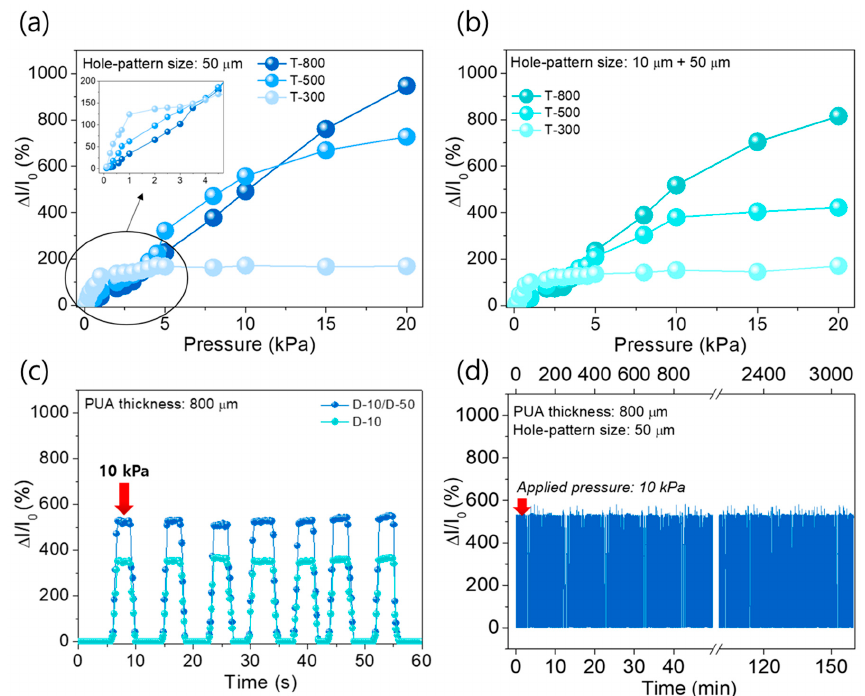
Figure 3. Analysis of static response and dynamic response to pressure with different PUA thickness, stretched state. ( a ) The relative current change of D-50 pressure sensors with different PUA thickness (300, 500, and 800 µm) up to 20 kPa. The inset shows the small pressure range (up to 4.5 kPa). ( b ) The relative current change of D-10 + 50 pressure sensors with different PUA thickness (300, 500 and 800 µm) up to 20 kPa. ( c ) The dynamic responses of D-50 and D-10 + 50 pressure sensor in 60 s. The sensors pressed on 10 kPa in 5 s and released repeatedly through pressing weight. ( d ) The cyclic test data of the pressure sensor for steady pressure sensing stability at a frequency of 0.1 Hz (about 3200 cycles).